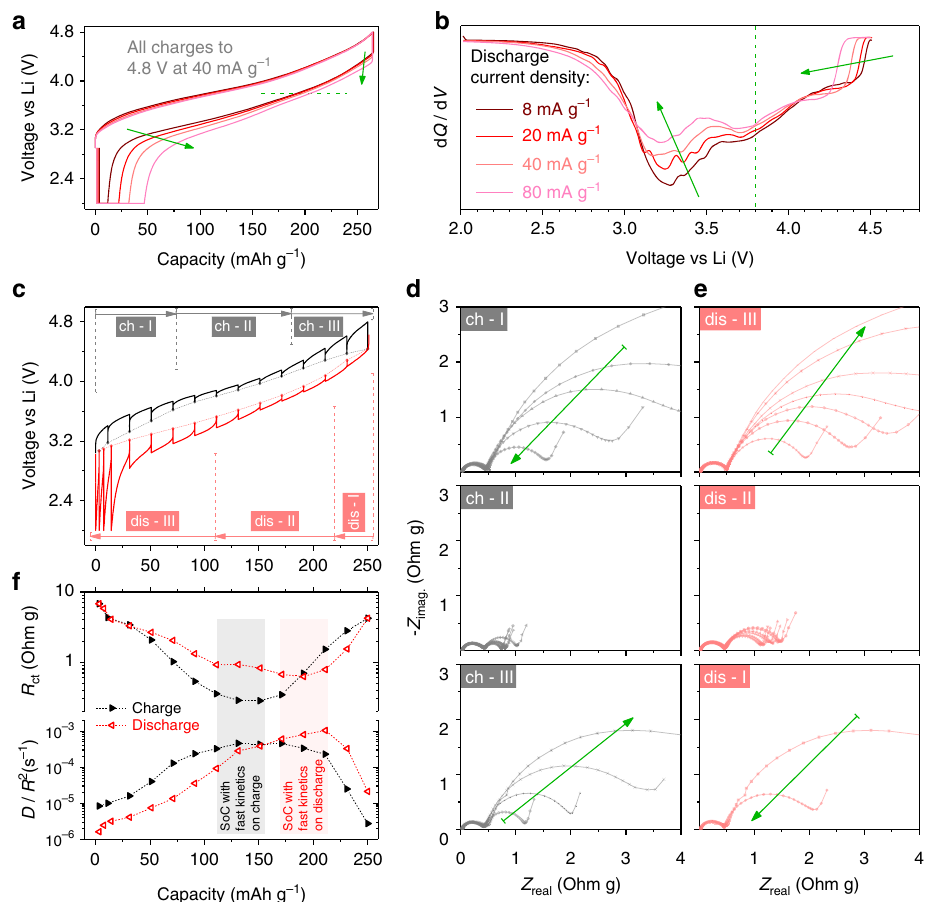
Fig. 5 Electrochemical kinetics as a function of SoC for activated LR-NMC. Effect of increasing discharge current densities on a half-cell voltage pro fi les and b corresponding d Q /d V curves. LR-NMC is fi rst activated by a few formation cycles in 2.0 – 4.8 V. Discharges end with a potentiostatic hold at 2.0 V, until the current decays to 2 mA g − 1 , ensuring identical Li stoichiometry at the beginning of each scan. Arrows show the shift of pro fi les as current increases. c The positive electrode ’ s voltage pro fi le in a three-electrode cell, recorded with a GITT protocol (40 mA g − 1 pulses with 4 h rests for equilibration). Circles denoting OCVs are connected with dashed lines to trace a voltage hysteresis loop. Impedance is measured at each step after the 4 h rest. For convenience, charge (black) and discharge (red) are divided into three segments each. During each segment, the evolutions of positive-electrode EIS Nyquist plots are shown for d charge (black) and e discharge (red). f The variation of charge-transfer resistance and diffusion coef fi cient as a function of SoC on charge and discharge paths. The equivalent circuit model used is shown in Supplementary Fig. 14. R ct is the charge-transfer resistance and D / R 2 is the reciprocal of time constant associated with the Li diffusion process, where D is the Li diffusion coef fi cient and R is the particle radius. The SoCs with fastest kinetics (minimum R ct and maximum D / R 2 ) are different on charge and discharge paths, as shaded in f with black (charge) and red (discharge),